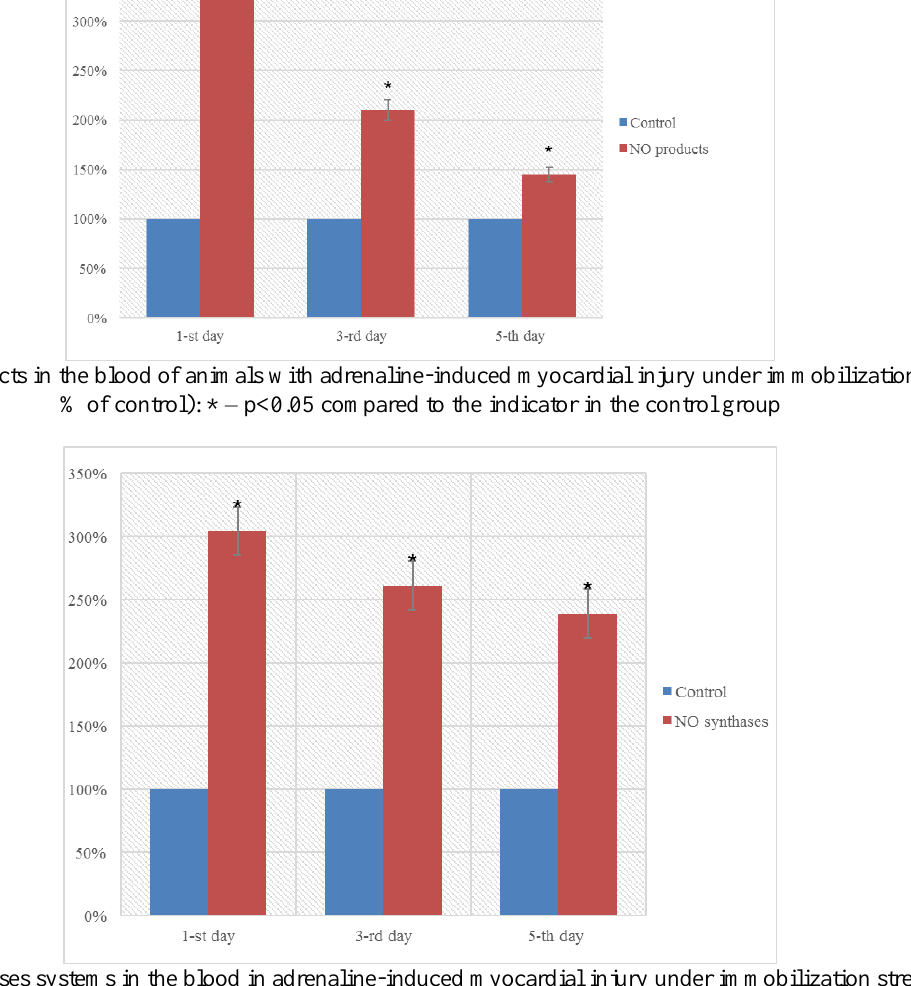
Fig. 2. NO synthases systems in the blood in adrenaline-induced myocardial injury under immobilization stress (in % of control): * – p<0.05 compared to the indicator in the control group